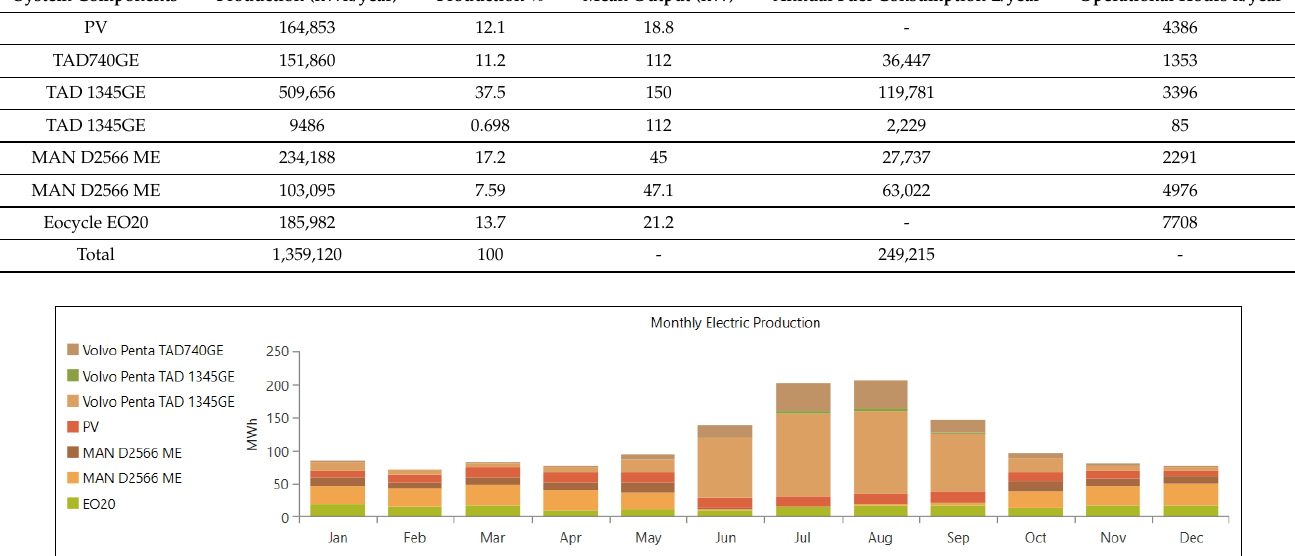
Table 9. Analytical Electrical Production and technical characteristics for optimal configuration of Scenario 1. System Components